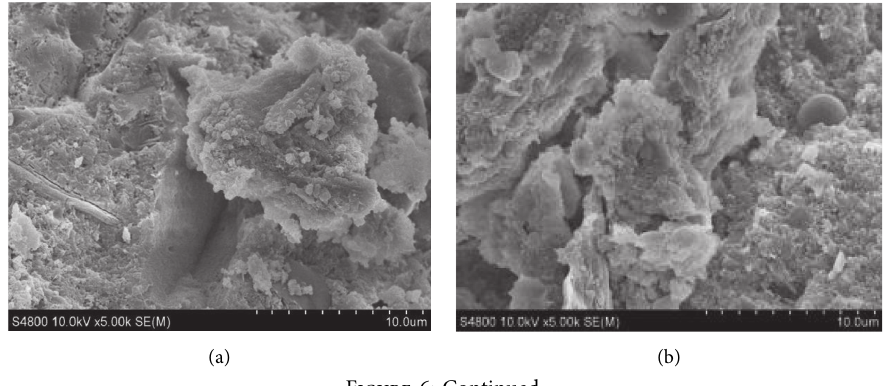
Figure 5: XRD pattern of HPC with different mineral admixtures. (a) Fly ash; (b) CFBC ash; (c) CFBC